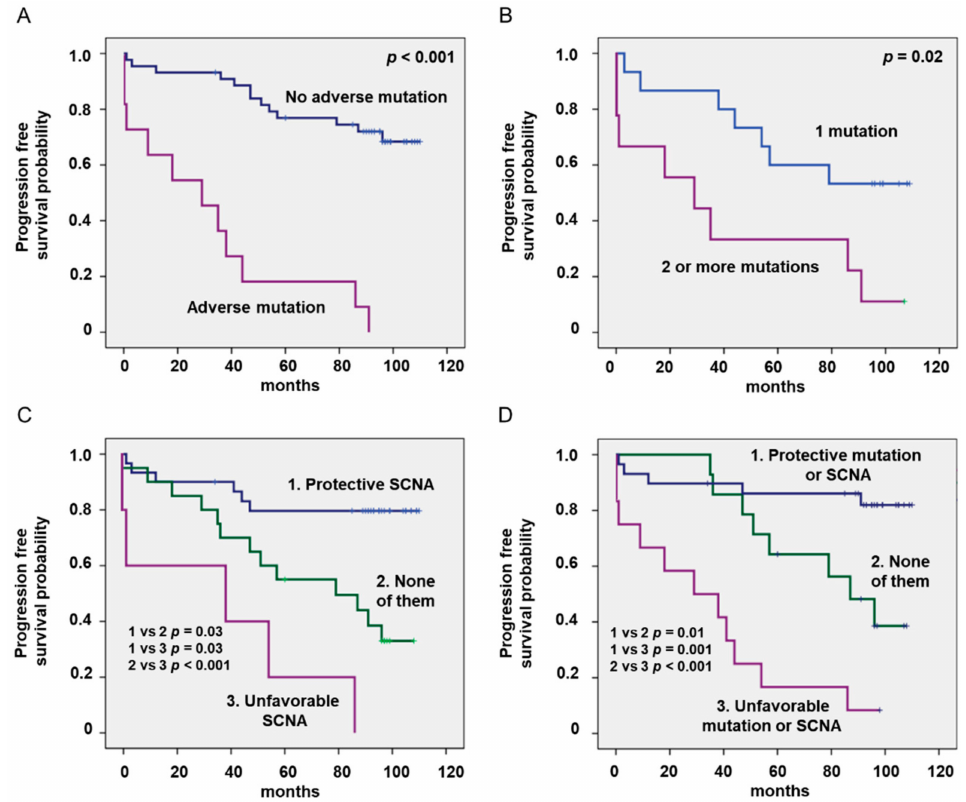
Figure 1. Kaplan–Meier curves of patients with chronic lymphocytic leukemia (CLL) stratified by the presence of adverse mutations ( A ), the accumulation of 2 or more mutation ( B ), single copy number abnormalities (SCNAs) ( C ) and combined prognostic groups ( D